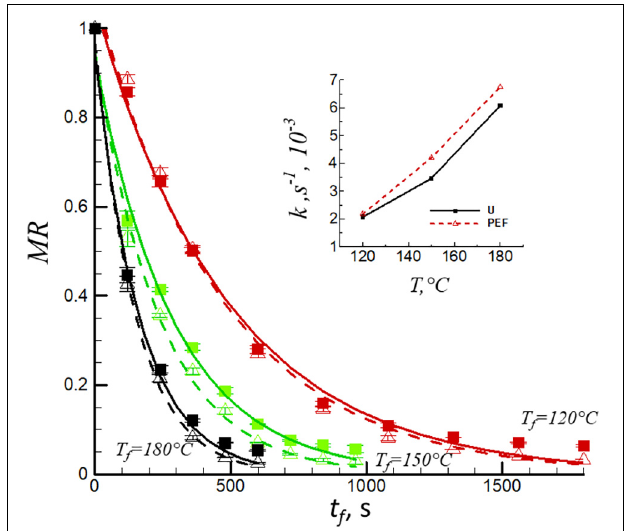
FIGURE 1 | Evaluation of moisture ratio, MR , of untreated (solid lines, filled squares) and PEF pre-treated (PEF) (dashed lines, open triangles) samples at different frying temperatures, T f = 120, 150, and 180 ◦ C. The lines were obtained by fitting the data with Eq. 4. Insert of Figure 1 shows the frying rate constant ( k ) for untreated (U) and PEF pre-treated